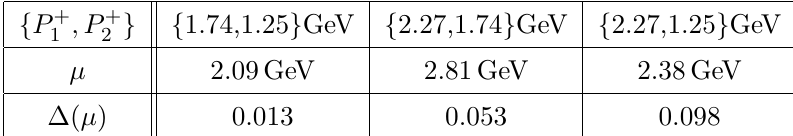
Figure 6 . Fit results for M [ F ] for different combinations of momenta { P 1 , P 2 } and cutoffs of the sta- ple length L . Note that the results for the two largest lattice momenta { P + have the largest statistical error, which can be explained with a more severe violation of Lorentz invariance and the dispersion relation at larger momenta.